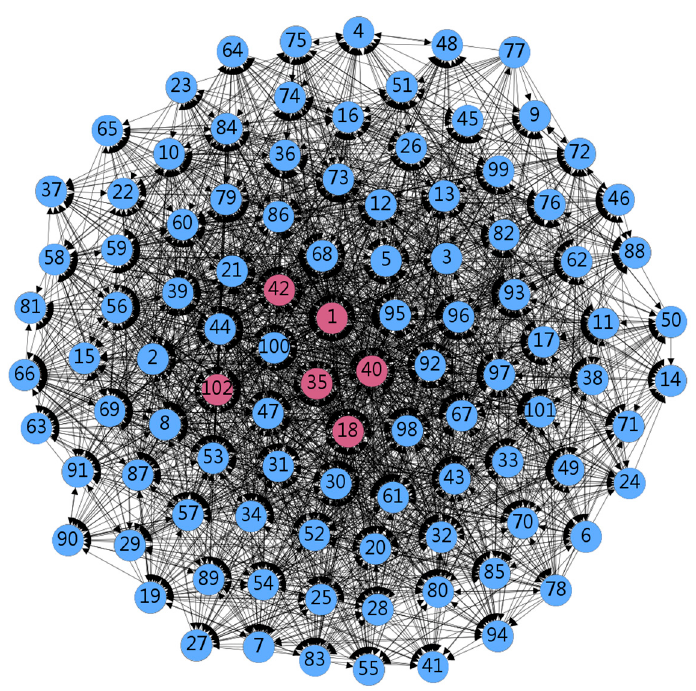
Figure 3. Doctor information interaction network structural hole analysis diagram.